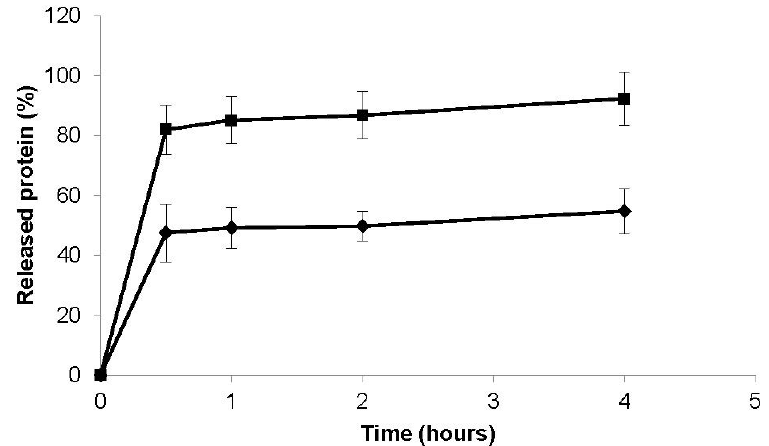
Figure 4. Release profiles of insulin ( ■ ) and FITC-BSA ( ♦ ) from CS/CHS nanoparticles (CS/CHS = 3:1, w/w) in PBS pH 7.4 at 37 °C (mean ± SD, n ≥ 3).